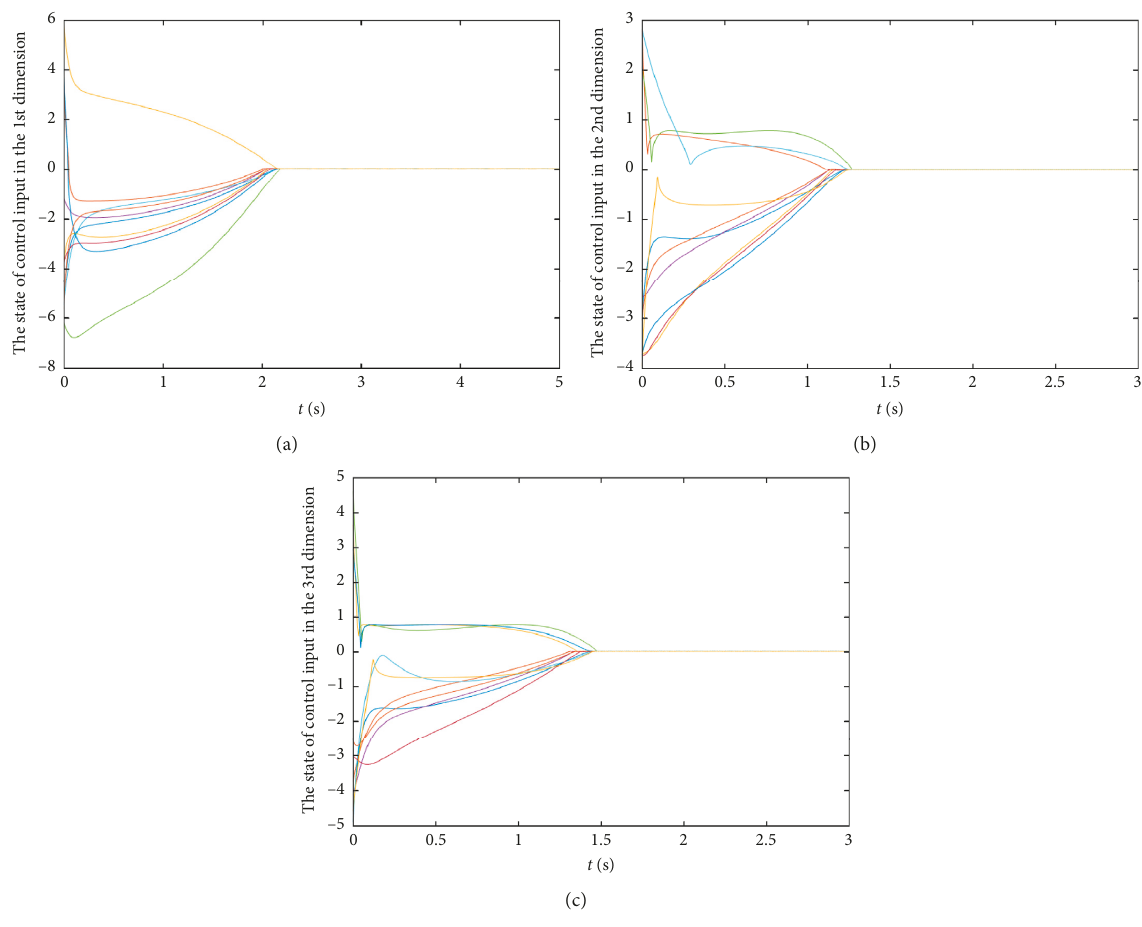
Figure 3: The state of the input u